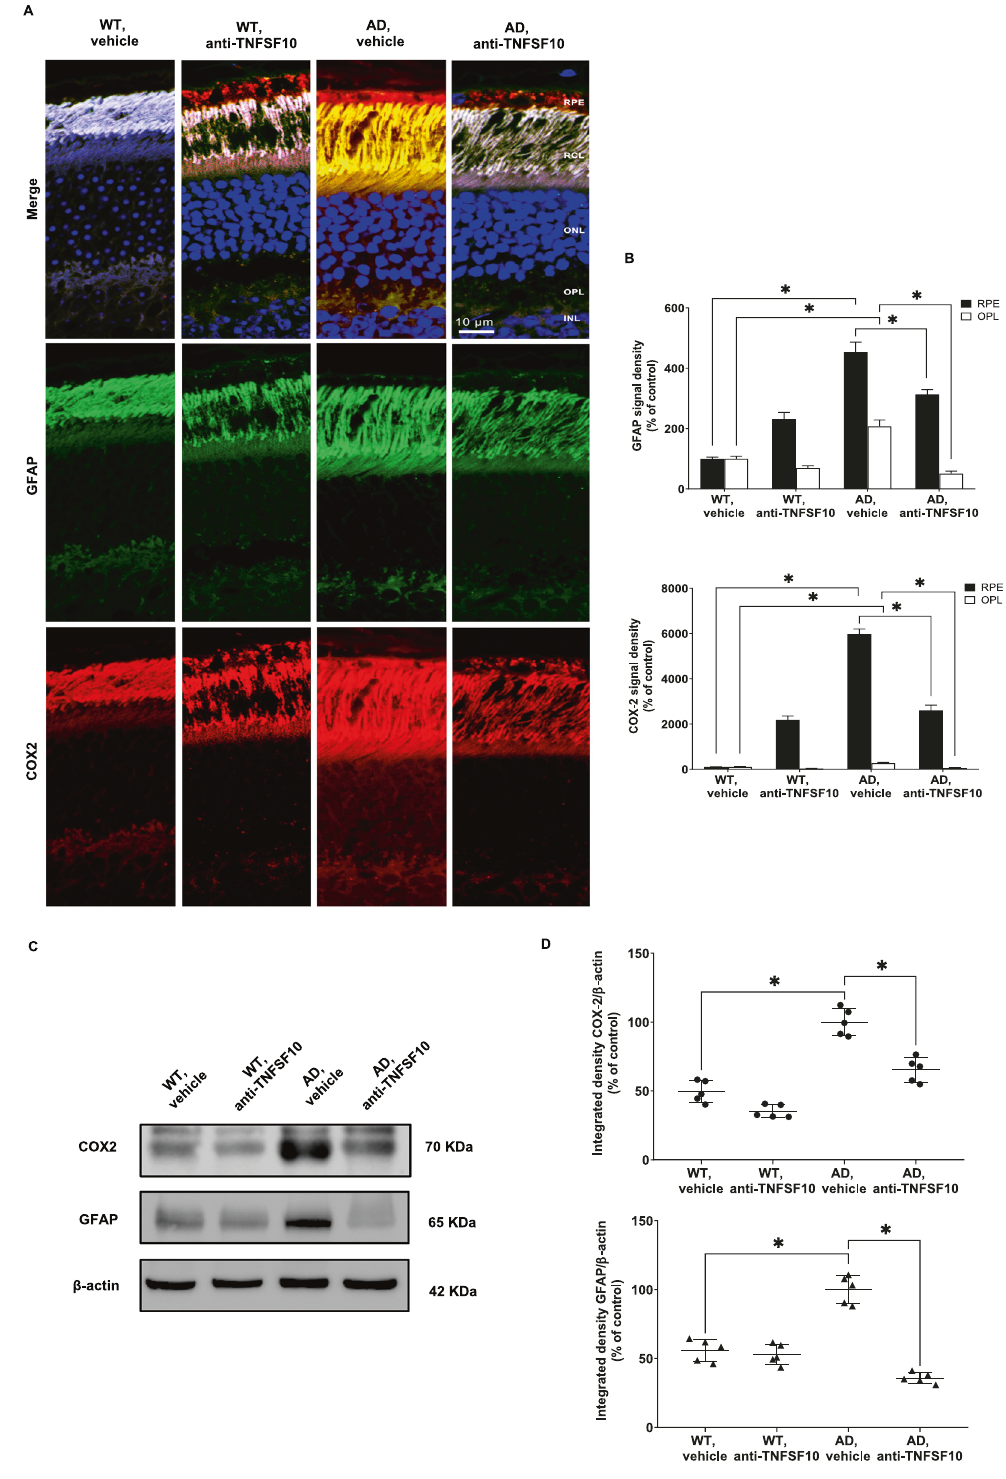
Fig. 7 Anti-TNFSF10 treatment inhibited astrogliosis in the outer-plexiform and in the RPE layers of the 3xTg-AD mouse retina. A Immunohistochemical staining for GFAP, COX2 in the retina of WT and 3xTg-AD mice treated with anti-TNFSF10 or vehicle. Original magni fi cation, x63. Scale bar = 10 µm. B Densitometric analysis of the GFAP and COX2 immuno fl uorescence signal in the RPE and OPL retinal layers. One-way ANOVA and post-hoc Tukey ’ s multiple comparisons test were used for statistical analysis. * p < 0.05. N = 5 animals; 5 independent retinal samples per group. For each retinal section, 14 optical fi elds were analyzed. C Western blot images for GFAP, COX-2 protein expression in the retina of mice following chronic treatment with an anti-TNFSF10 monoclonal antibody or vehicle. D Densitometric analysis of western blots. Data are expressed as mean ± standard deviation. One-way ANOVA and post-hoc Tukey ’ s multiple comparisons test were used to determine statistical signi fi cance. * p < 0.05. N = 5 animals; 5 independent retinal samples, 2 pooled retinas per sample in each